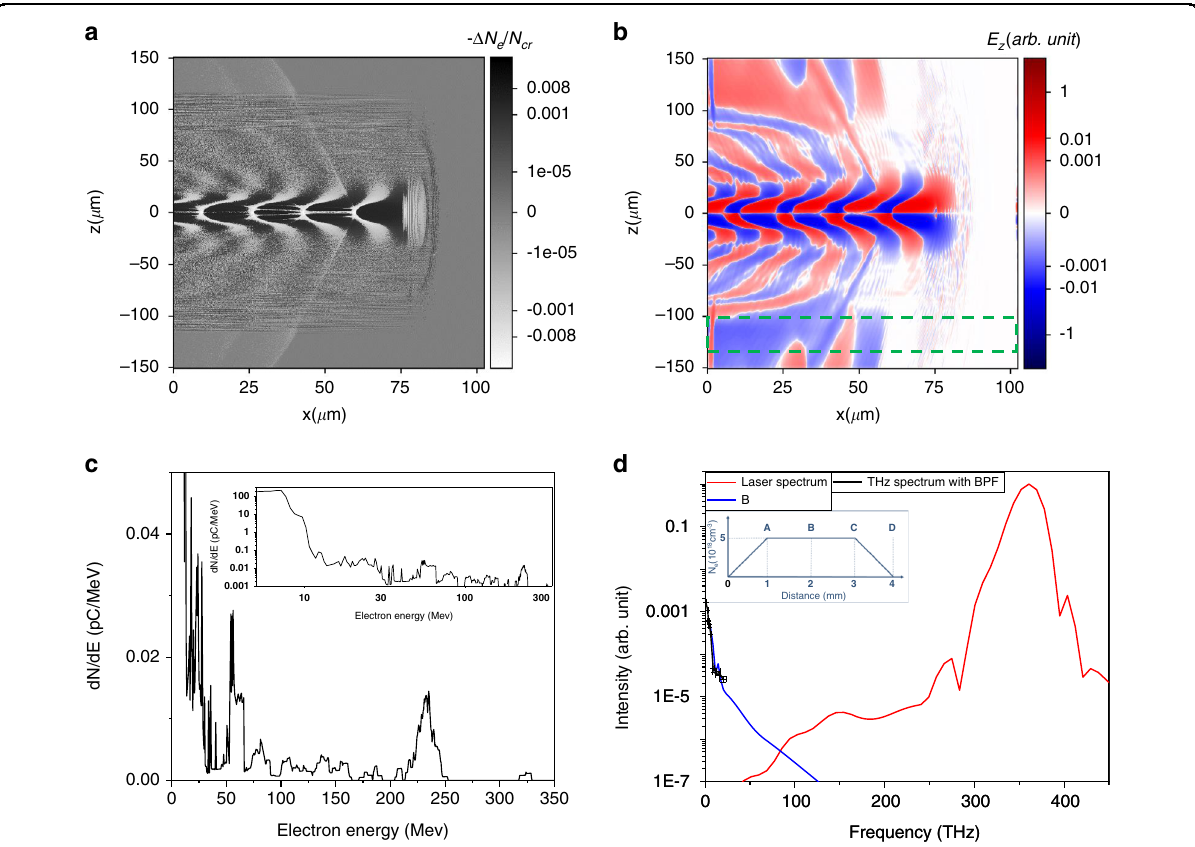
Fig. 5 PIC simulation results for pure helium obtained with ɑ 0 = 1.9 and plasma density of 5 × 10 18 cm − 3 . a Plasma electron density modulation ( − Δ N e ) normalized by N c and b E z distribution after the laser propagating over 3 mm in He. c Electron energy spectra. Inset: y-axis on a log scale. d Fourier spectrum (blue line) of E z ( x ) summed over z = 100 − 130 μ m calculated at Point B in the trapezoidal density pro fi le (inset), coplotted with the laser spectrum (red line) and measured THz spectrum (black line) retrieved from Fig. 4a with the detector ’ s responsivity and fi lter/ window transmission curves included (see Figs. S3b and